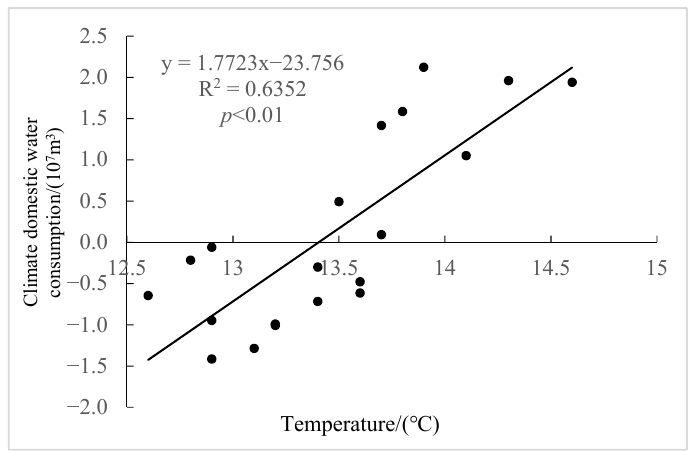
Figure 6. Regression analysis of climate domestic water consumption and mean temperature.